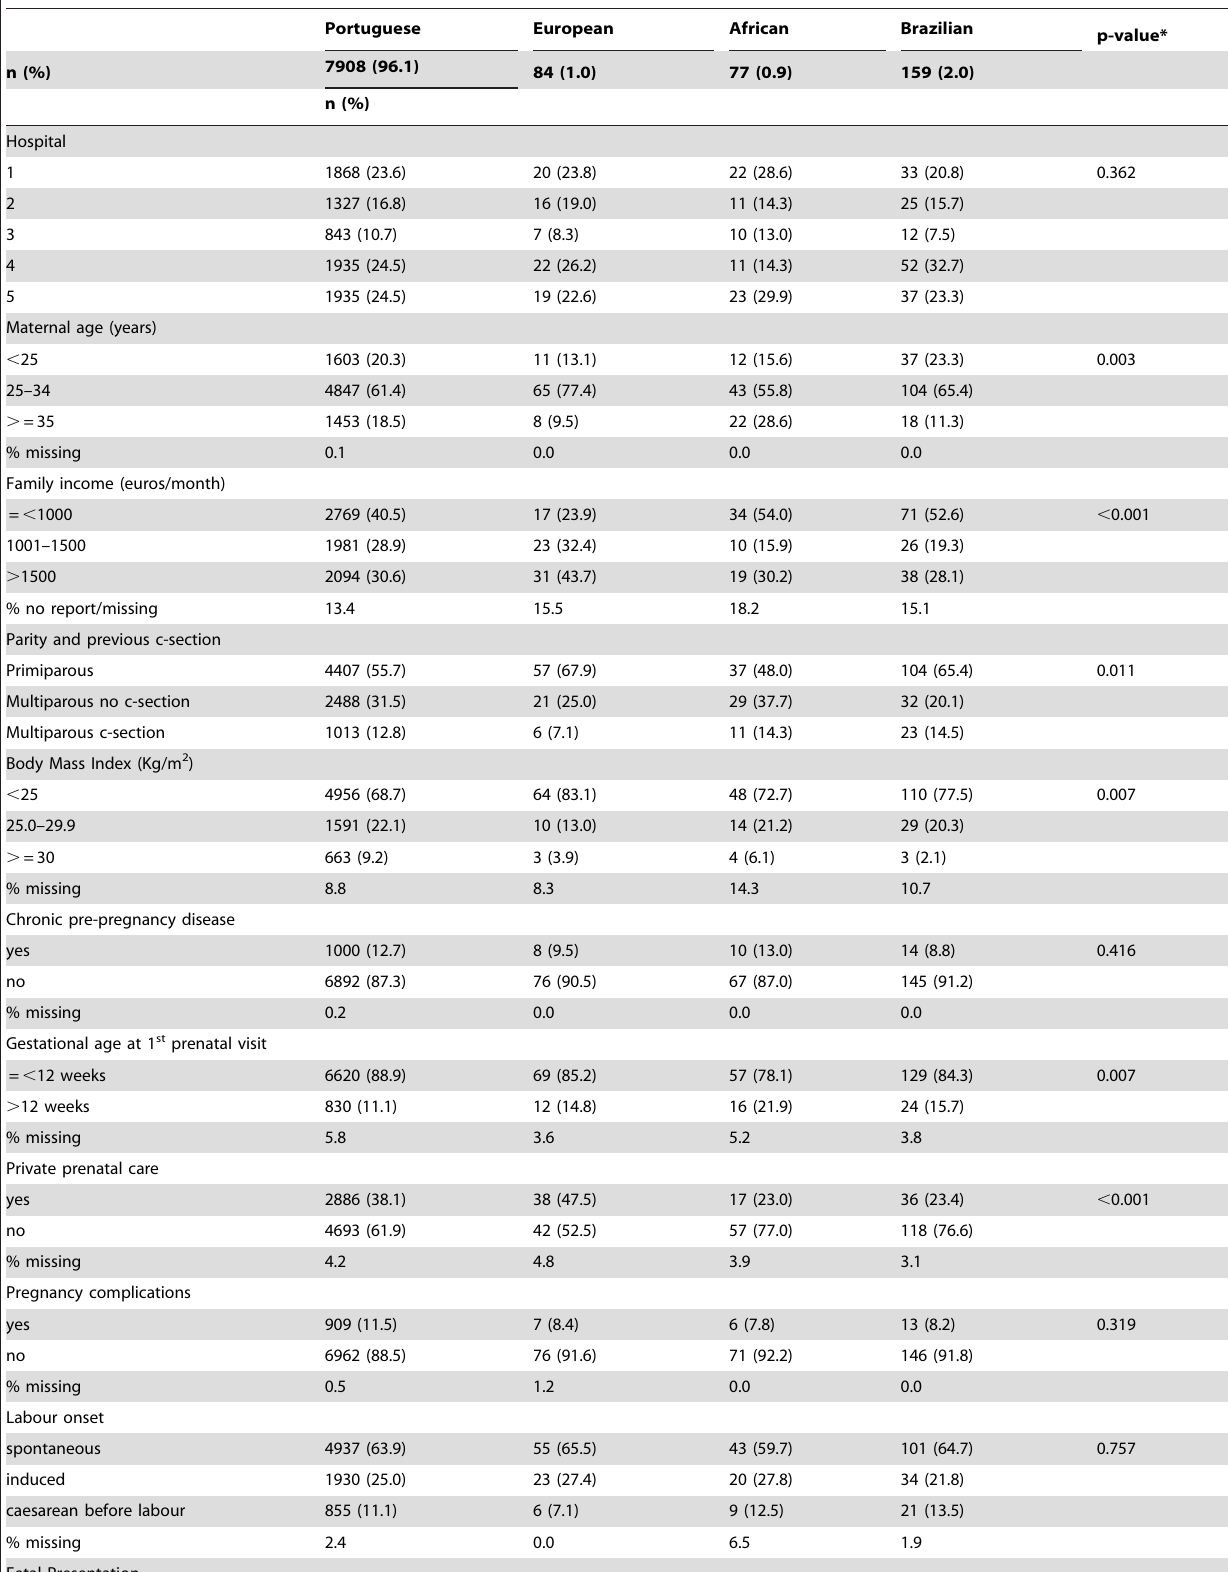
Table 1. Social demographic and obstetric characteristics by country of origin.